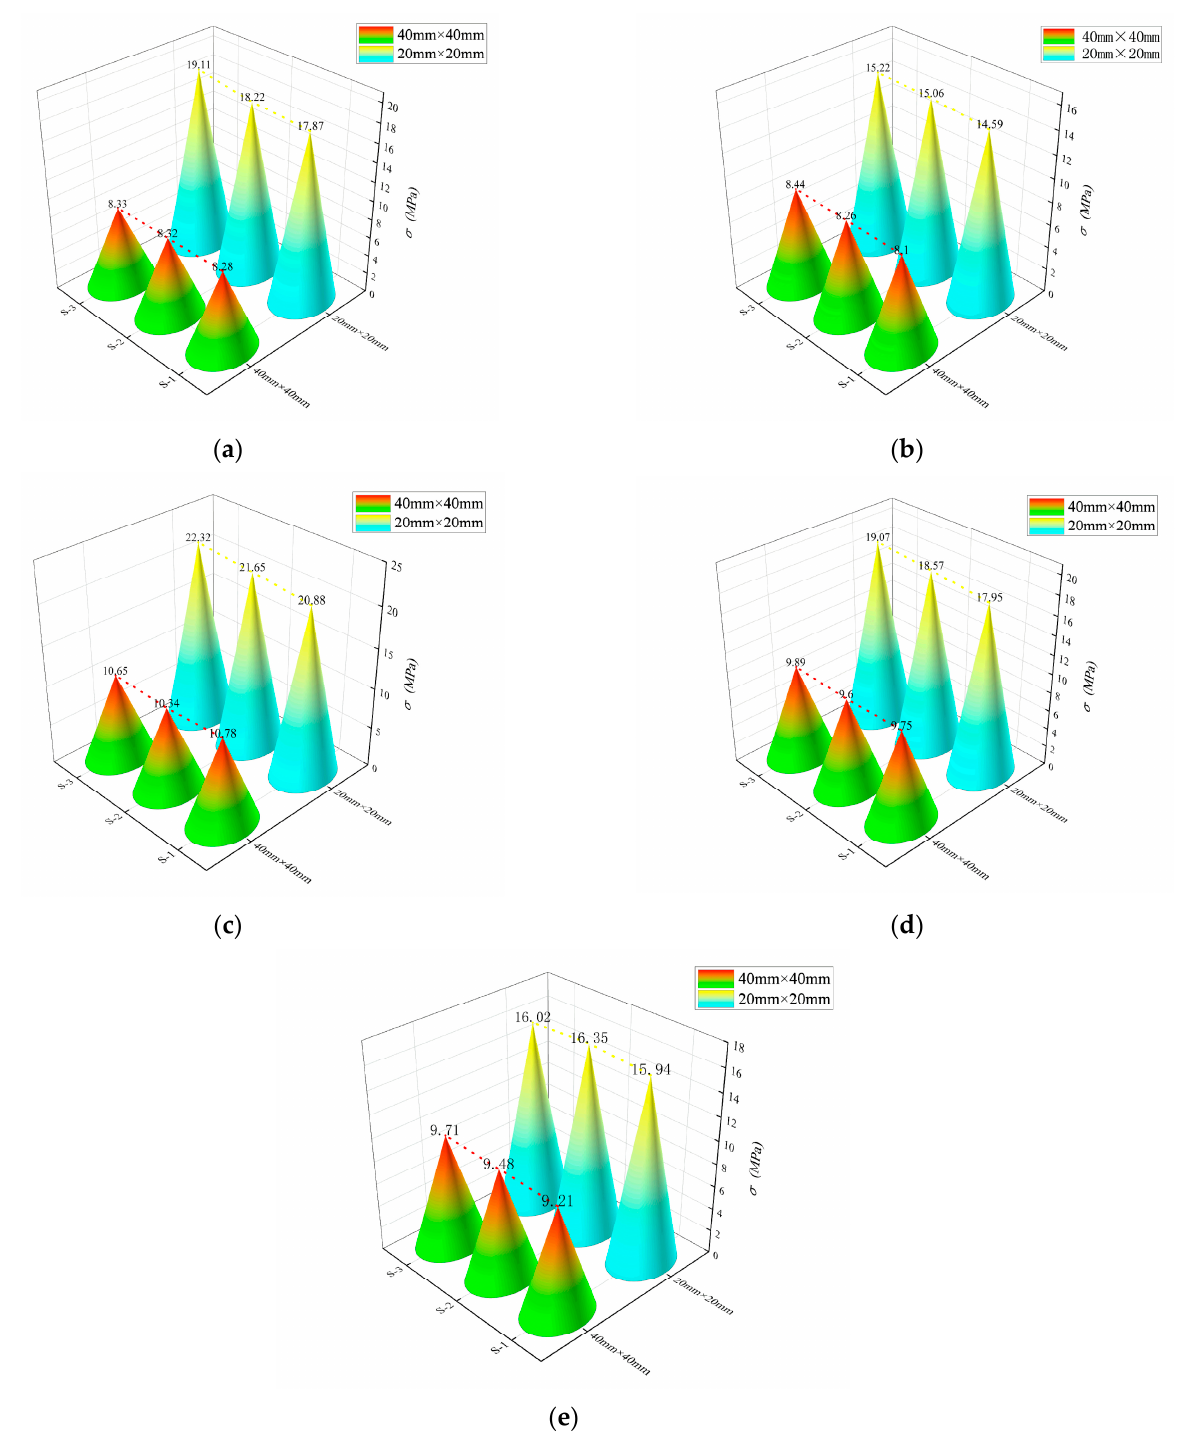
Figure 8. Ultimate bending stress of BTRC plates with different grid sizes. ( a ) SL-OG-BTRC20(40); ( b ) DL-OG-BTRC20(40); ( c ) DL-NOG-BTRC20(40); ( d ) DL-NOG-BTRC20(40); ( e ) DL-NOG60- BTRC20(40).